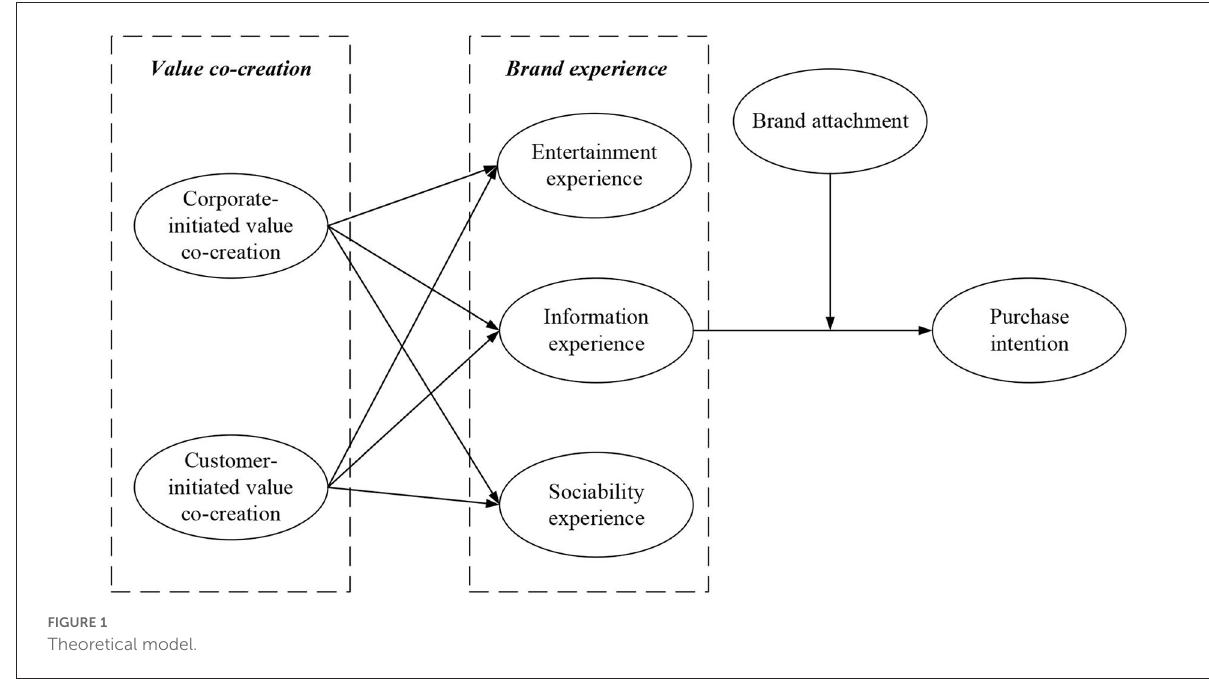
TABLE 1 Variables and measurement